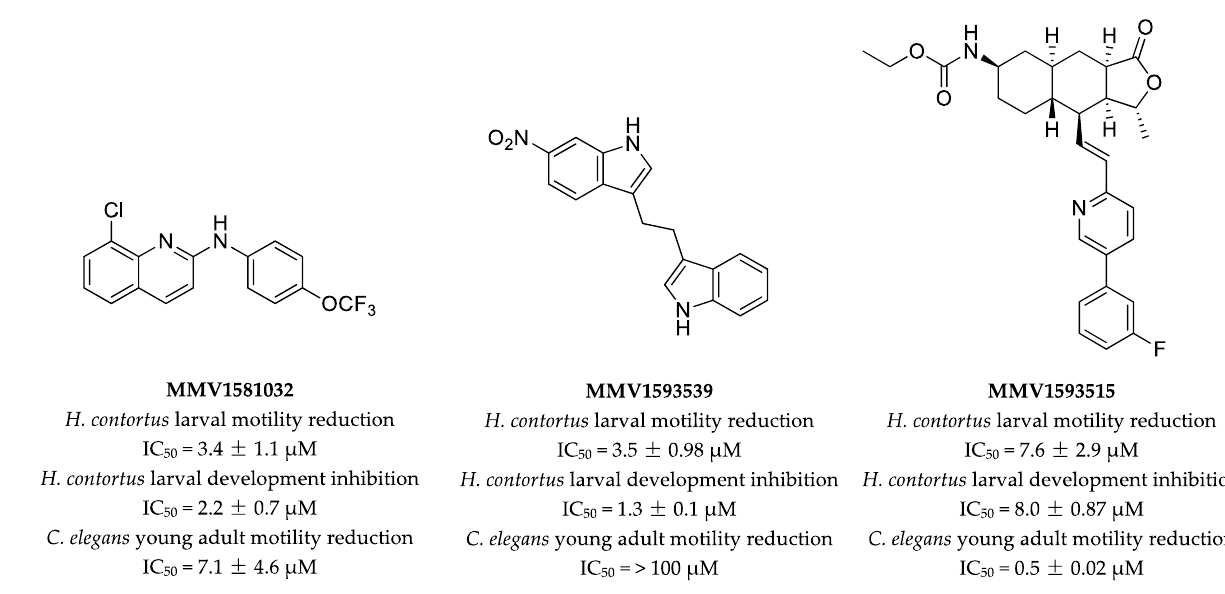
Figure 5. Chemical structures of MMV1581032, MMV1593539 and MMV1593515. Half of the maxi- mum inhibitory concentration (IC 50 ) values of each compound were established for the inhibition of H. contortus larval motility at 90 h, the inhibition of larval development of H. contortus at seven days and the reduction of motility of young adults of C. elegans at 40 h. The IC 50 values are presented as mean ± standard deviation. Three independent assays were conducted in triplicate.